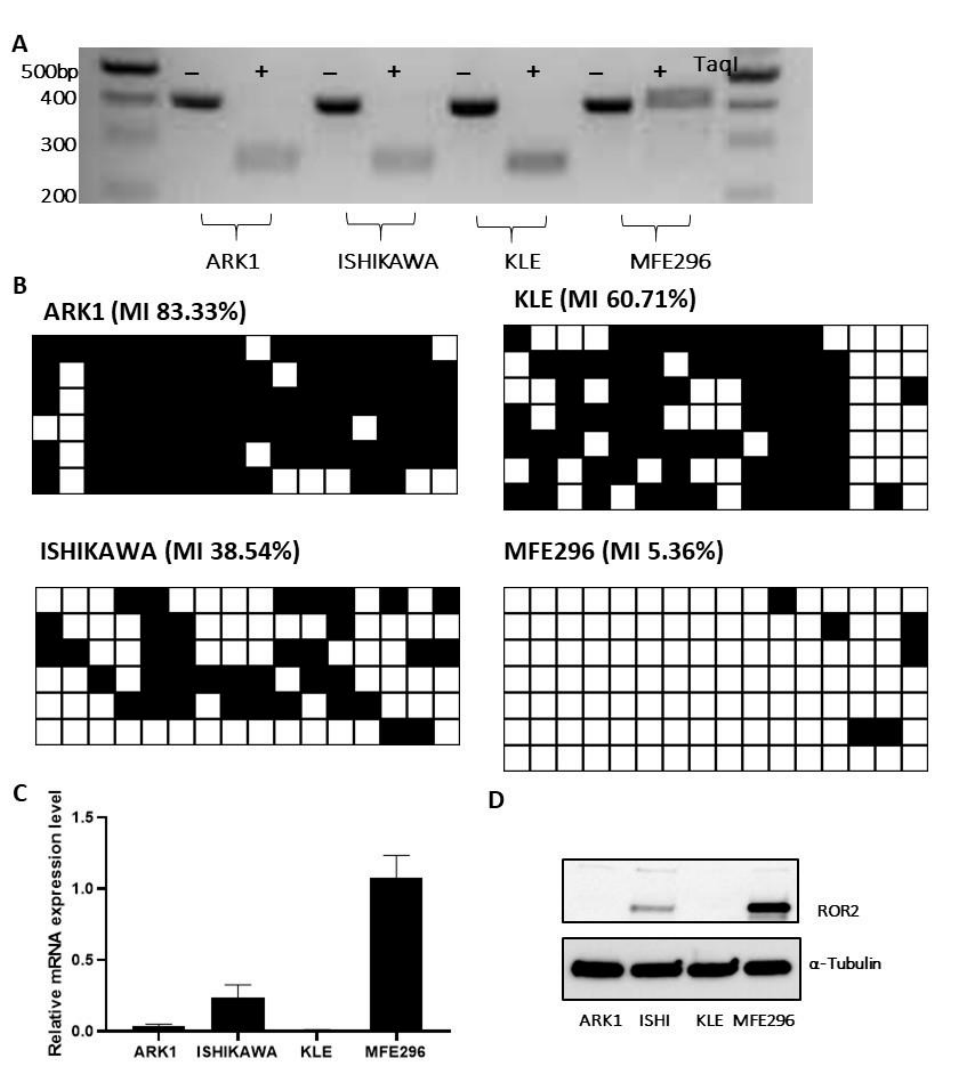
Figure 4. ROR2 expression was suppressed in the high grade and serous EC cell lines via hypermethylation within the ROR2 promoter region. ( A ). COBRA assay of 4 EC cell lines (ARK-1, ISHIKAWA, KLE and MFE296) showing PCR amplicons (395 bp) with and without TaqI digestion. Methylation is detectable as digestion of the amplicon at 295 bp and 100 bp fragments. Samples without methylation exhibit no digestion. ( B ). Bisulphite sequencing of the four EC cell lines. Black squares represent methylated CpG dinucleotides. White squares represent unmethylated CpG dinucleotides. ROR2 hypermethylation is observed in ARK-1 and KLE. MI = Methylation Index. ( C ). ROR2 mRNA expression in EC cell lines measured by qRTPCR and normalised to 3 housekeeping genes ( n = 3). Error bar represents standard deviation. ( D ). ROR2 protein expression in EC cell lines analysed by Western blot. Normalised intensity of bands and whole blots were provided in Figure S4.